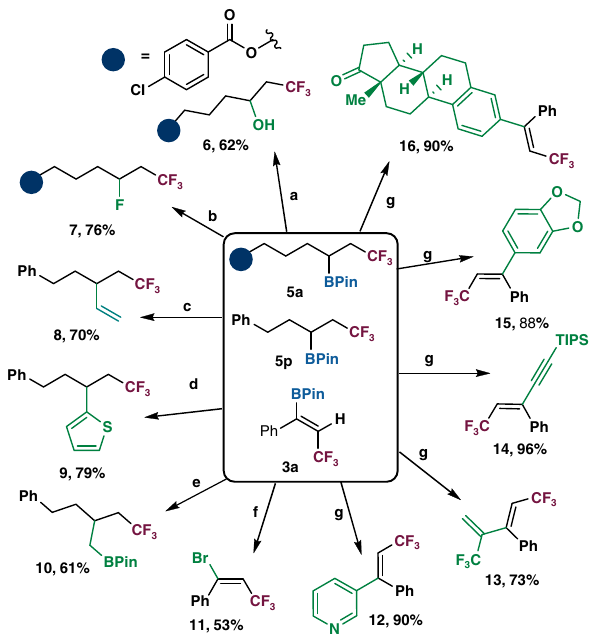
Fig. 4 Further transformations. a H 2 O 2 (30%), NaOH (3 M), THF, 0 °C to rt. b Select fl uor, AgNO 3 , TFA, H 3 PO 4 , DCM/H 2 O, 50 °C. c